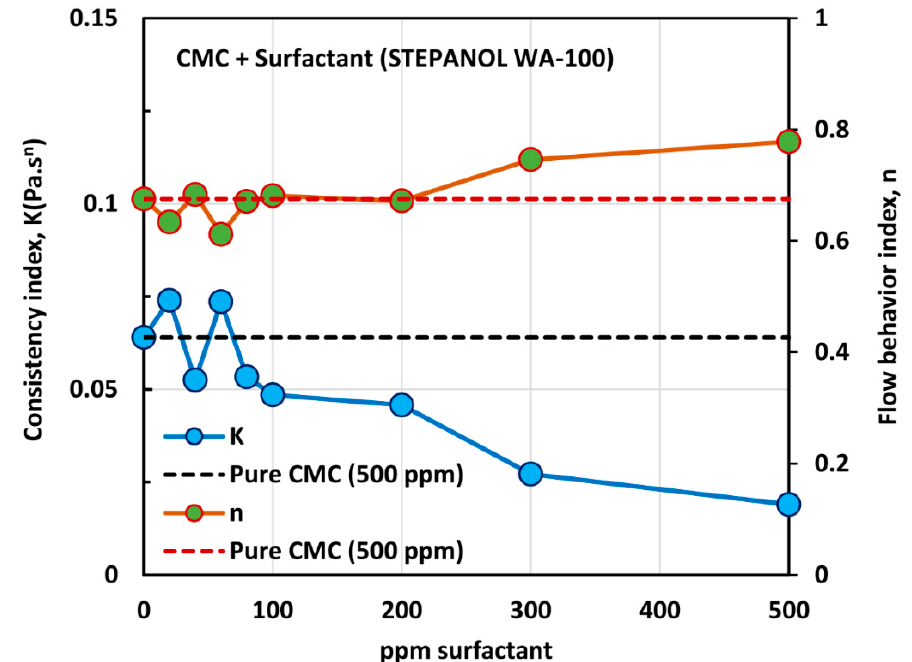
Figure 9. Variations of consistency index, K , and flow behavior index, n , for mixtures of anionic polymer CMC and anionic surfactant Stepanol WA-100 with the increase in surfactant concentration, at a fixed polymer concentration of 500 ppm.